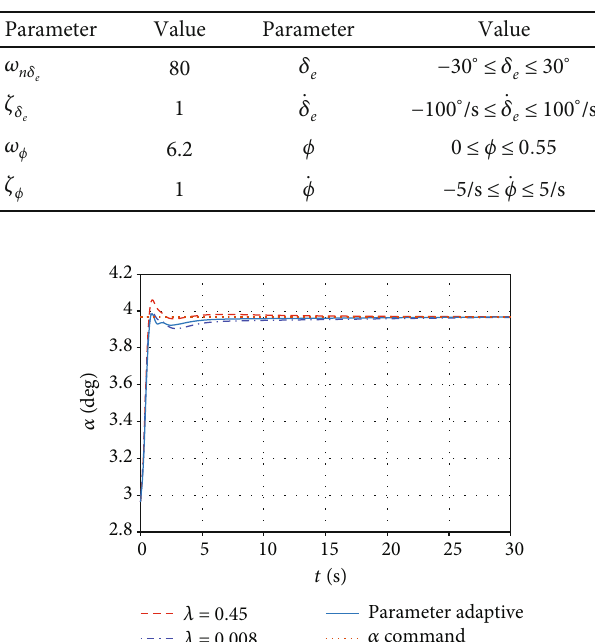
Table 5: Actuator parameters.